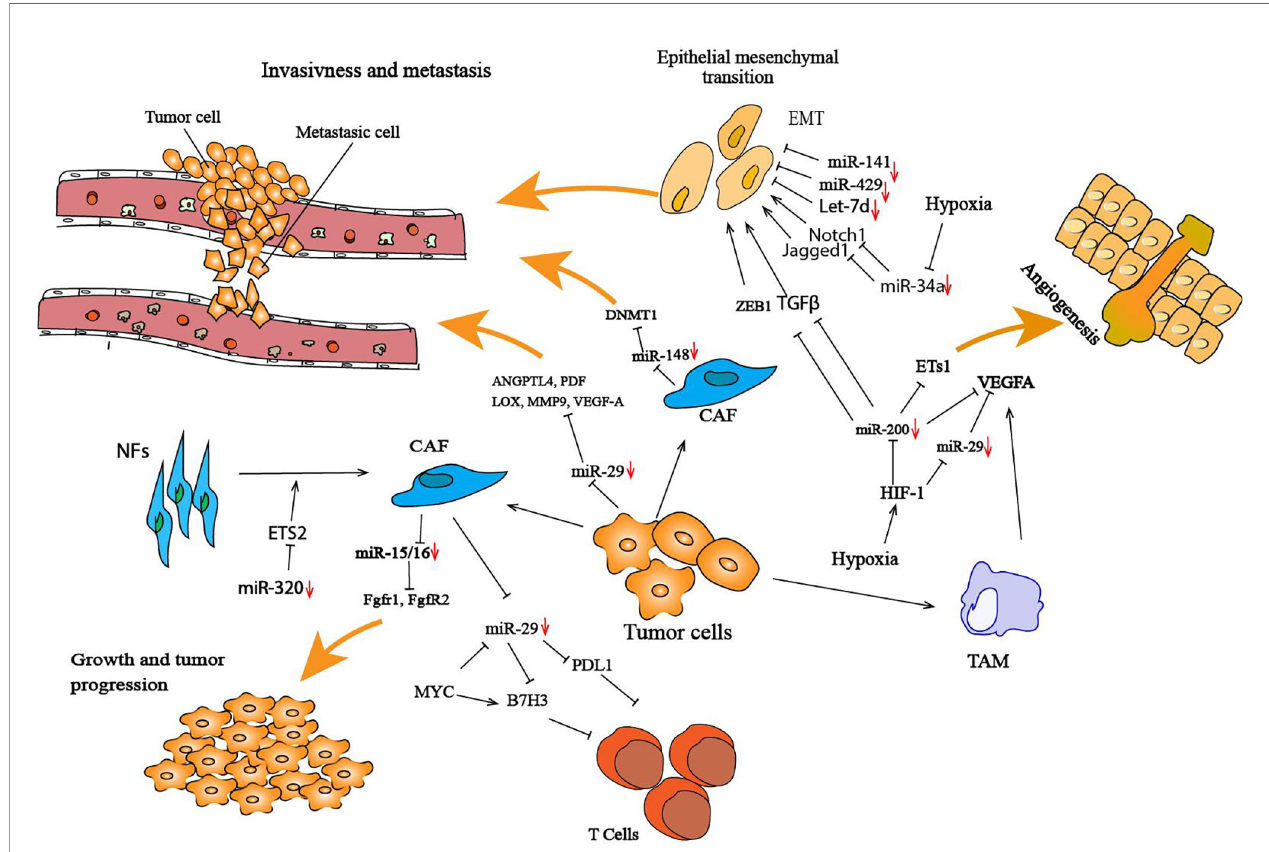
FIGURE 2 | Illustration of cancer cells and the tumor microenvironment-deregulated TS miRNAs that lead to tumor development and progression. In the tumor microenvironment, miRNAs regulate the interaction between cancer cells and their surrounding microenvironment by targeting several genes involved in this interaction. Several TS miRNAs are deregulated in the tumor microenvironment; for example, miR-29 and mR-148 are both downregulated in CAFs, and this deregulation promotes cancer cell invasion and metastasis. These miRNAs have been found to negatively target several genes that are crucial in enhancing cancer metastasis, such DNMT1 for miR-148 and ANGPTL4, PDF, LOX, MMP9, VEGF-A for miR-29. Hypoxia in the tumor microenvironment has a protumorigenic role by altering the expression of TS miRNAs, such as miR-200, miR-34, miR-29 and miR-15/16. Inhibition of miR-200 can signi fi cantly increase the expression of Ets-1, resulting in the promotion of angiogenesis. HIF-1 is one of the most studied genes in hypoxia that plays a crucial role in the tumor microenvironment and has been associated with the downregulation of miRNAs. CAFs play an important role in cancer cells during initial cancer and metastasis processes. miR-320 is a TS miRNA that is known to play a part in transforming NFs to CAFs. miR-320 targets ETS2, a cancer-speci fi c transcription factor, resulting in increased oncogenic secretome secretion, and this oncogenic secretome converts NFs to CAFs in the tumor microenvironment